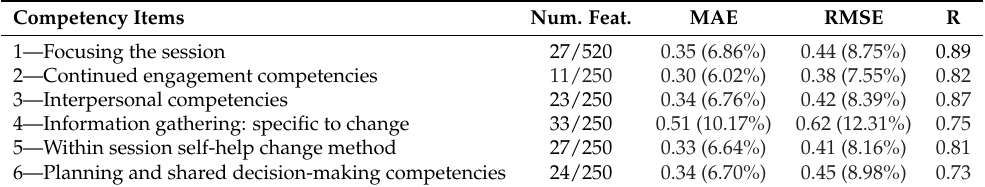
Figure 3. The actual versus predicted total practitioner’s competence measure highlighting each level of competence. Table 4. The competency rating prediction results based on each item using Lasso for manual transcriptions (the MAE and RMSE percentage of the total